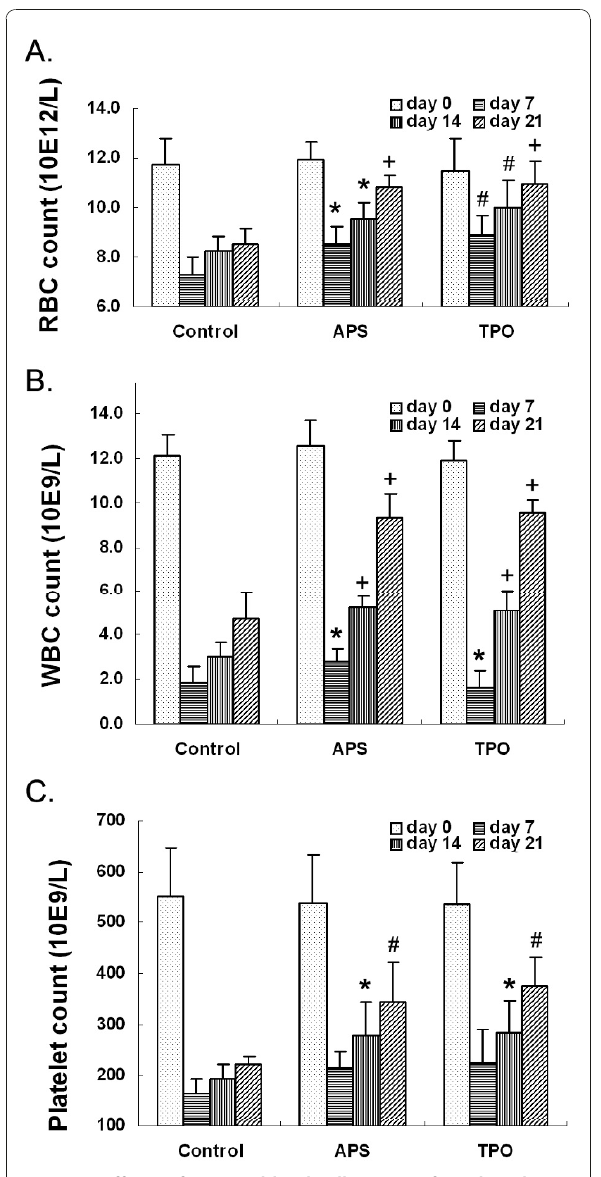
in vehicle- and TPO-treated animals on day 7 after irra- days 14 and 21 were significantly smaller than those in the control group. Similarly, TPO treated mice showed signifi- cantly smaller body weight on days 14 ( p < 0.001) and 21 ( p < 0.001). In the comparison of organ size (Figure 3B), spleens in the APS-treated mice were significantly larger